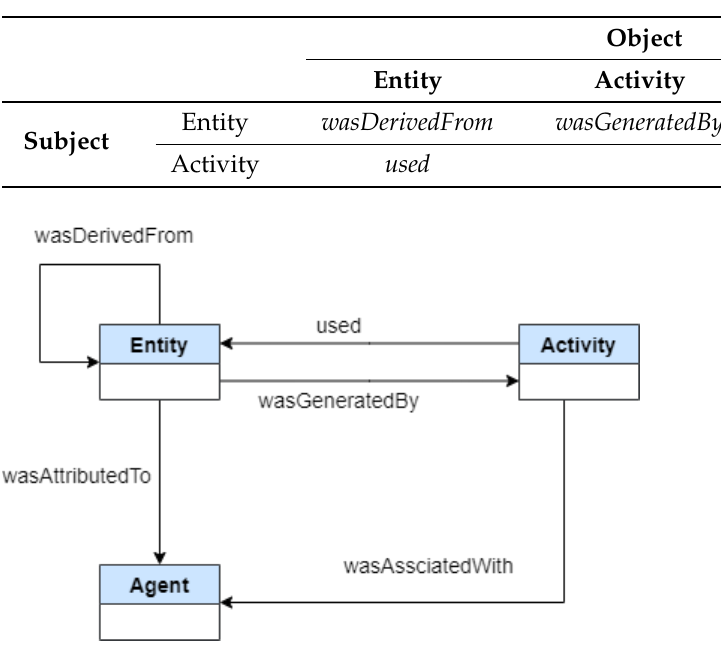
Table 1. PROV relations supported in our prototype.